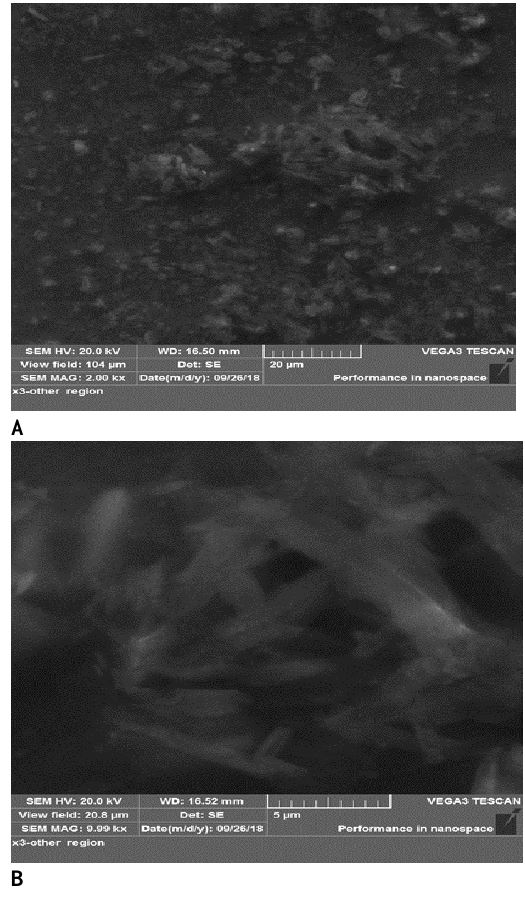
Figure13. A and B , illustrates crystal morphology